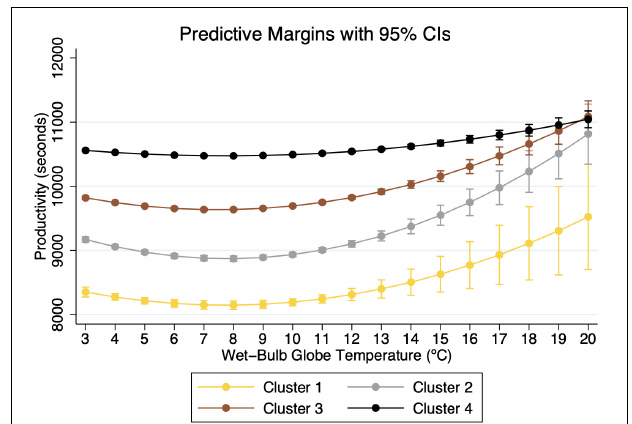
FIGURE 2 | Marginal Impact of WBGT on performance by clusters.